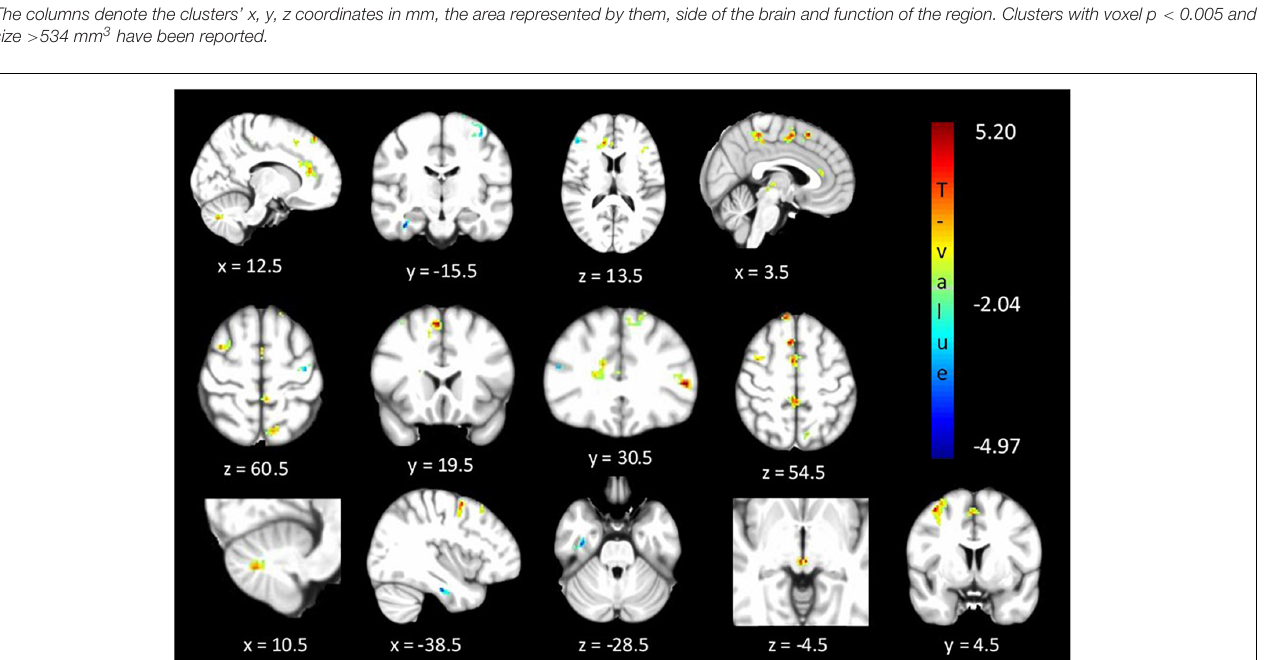
Visual-motor coordination, motor execution, saccades